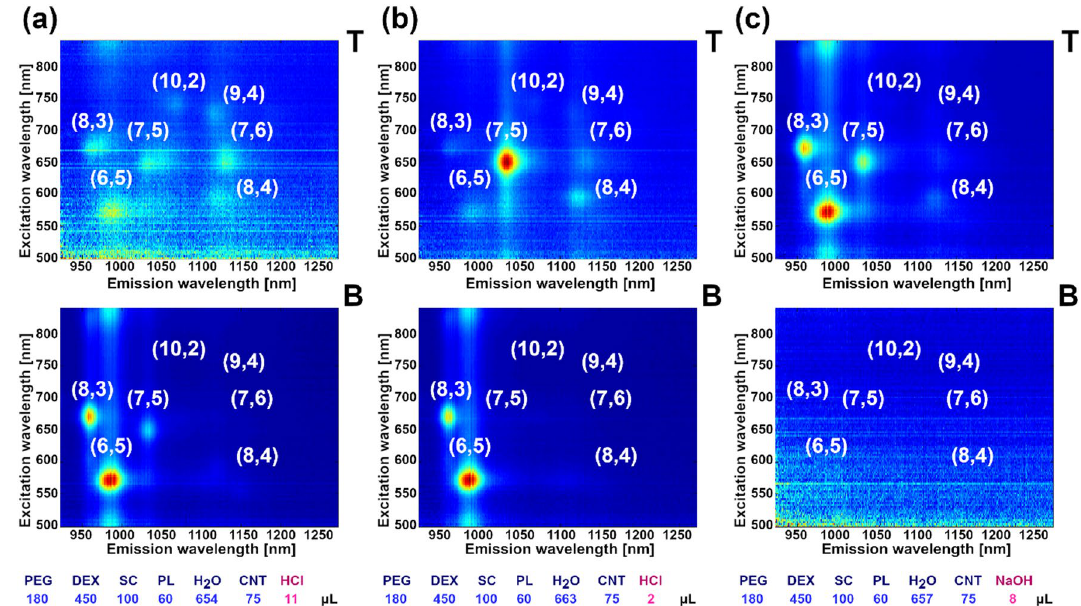
Figure 5. 2D PLE maps of SC-dispersed, (6,5)-enriched SWCNTs sorted by ATPE upon varying pH conditions. pH was modulated using: ( a ) 11 µL HCl, ( b ) 2 µL HCl and ( c ) 8 µL NaOH. 2D PLE maps of remaining samples are shown in Supplementary Animation 6. Analogous data for unsorted SWCNTs is given in Fig. S6 and Supplementary Animation (8,3), (6,5) as the pH was increased. Evidently, the previously reported mechanism is not valid in our parameter space. This may have been due to the choice of surfactant, as we used a trihydroxy bile acid salt SC in contrast to bihydroxy DOC employed by the authors 38 . SC, in contrast to DOC, does not aggregate at low pH to form micelles of higher order 53–55 . Below pH 6.0, we expect to see first signs of protonation of SC which gives less soluble cholic acid (CA, pKa of 4.98). At this pH, about 1 in 10 SC molecules is in the form of undissociated CA. Therefore, when the pH decreases further, more SC gradually strips from the SWCNT surface (when transformed to CA), and the exposed surface becomes available to Pluronic. Once Pluronic adsorbs onto the exposed SWCNT surface, it increases the affinity of selected CNTs towards the top phase, due to affinity of Pluronic to PEG as shown above. We hypothesize that at low pH, large diameter SWCNTs are encapsulated to a larger degree with Pluronic rather than SC, which may explain why these SWCNTs preferentially move to the top phase. Bile acid salt surfactants have a demonstrated affinity towards low diameter SWCNTs 56 , so when the content of SC in the biphasic system is limited at low pH, these molecules selectively adsorb onto small diameter species, which keeps these SWCNTs in the bottom phase. On the other hand, addition of a minute amount of 0.1 M NaOH moved virtually all (8,3) and (6,5) SWCNTs to the top phase. It is important to point out that nuclease-free water used for the study is slightly acidic by default (pH ~ 6.0), thus the data points at 0 µL of either HCl or NaOH do not correspond to neutral pH. These small amounts of NaOH provoked a final shift of the smallest-diameter species to the top phase when they to overcome the mild acidic environment of the biphasic system, which was necessary for the shift. Lastly, we report that these experiments were conducted at a reduced content of SC from 150 to 100 µL, so that the SWCNTs would exhibit lower affinity to the bottom phase, which made the system more sensitive to the variations in pH. We also observed that excessive content of acid or base causes expected quenching of the photoluminescence emission from SWCNT dispersions 57 .